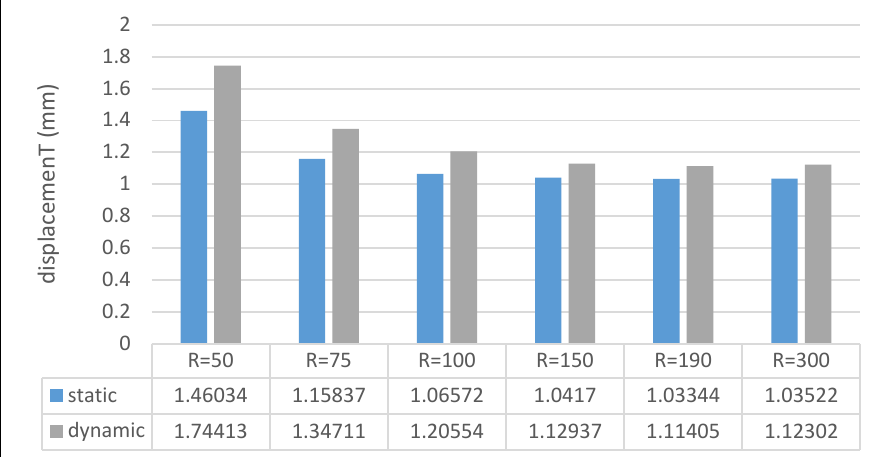
Fig. 7. Displacement response with different radii.